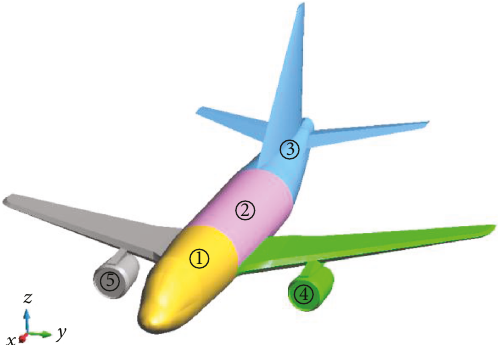
Figure 9: Currents over the missile obtained with an MLFMA simulation.